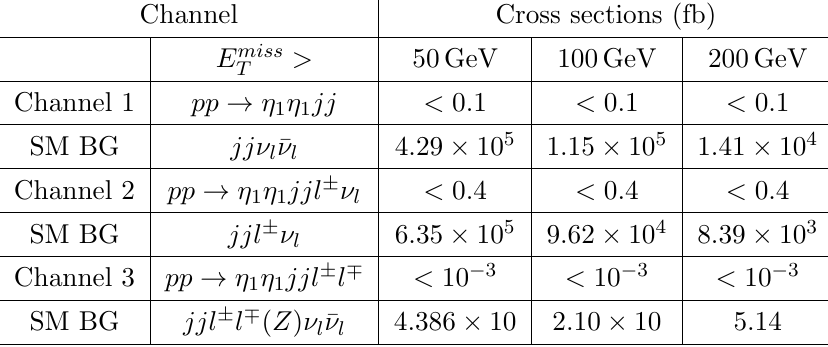
cuts, for (cid:18) = 0 : 2. The T